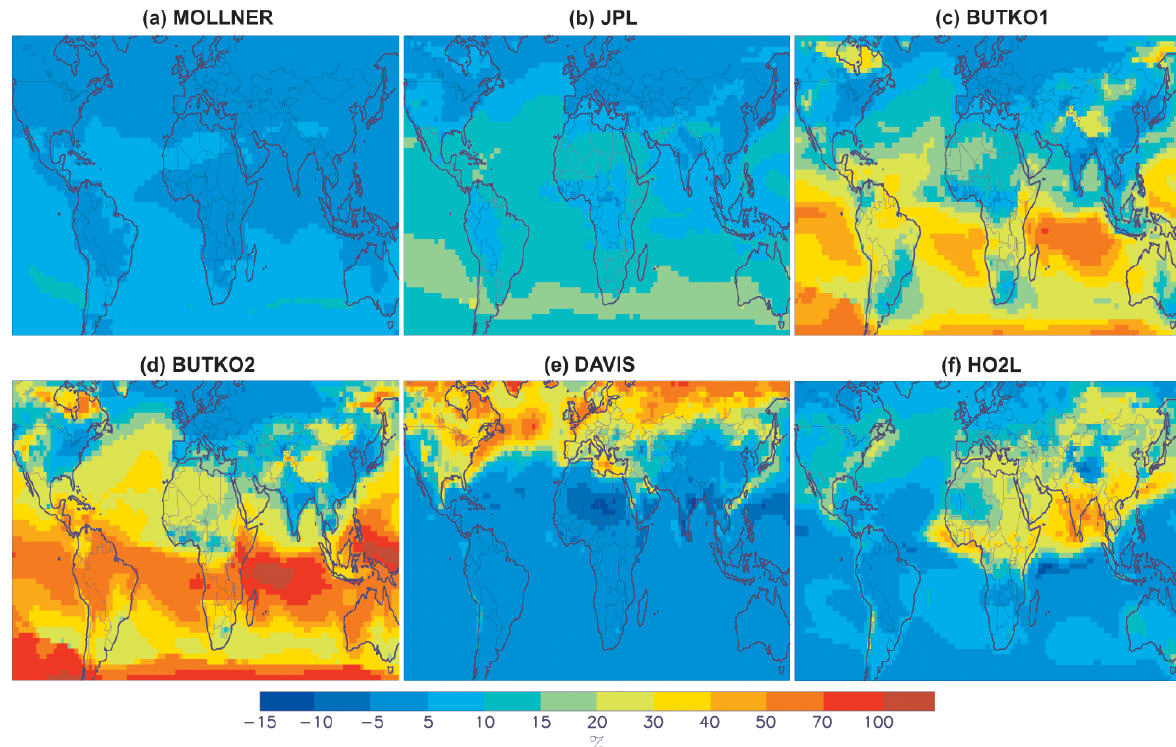
Fig. 2. Percentage difference in the sink rate of the tropospheric NO x column between the simulations of Table 1 and the base run MINLOSS ((RUN-MINLOSS)/MINLOSS)*100, for January